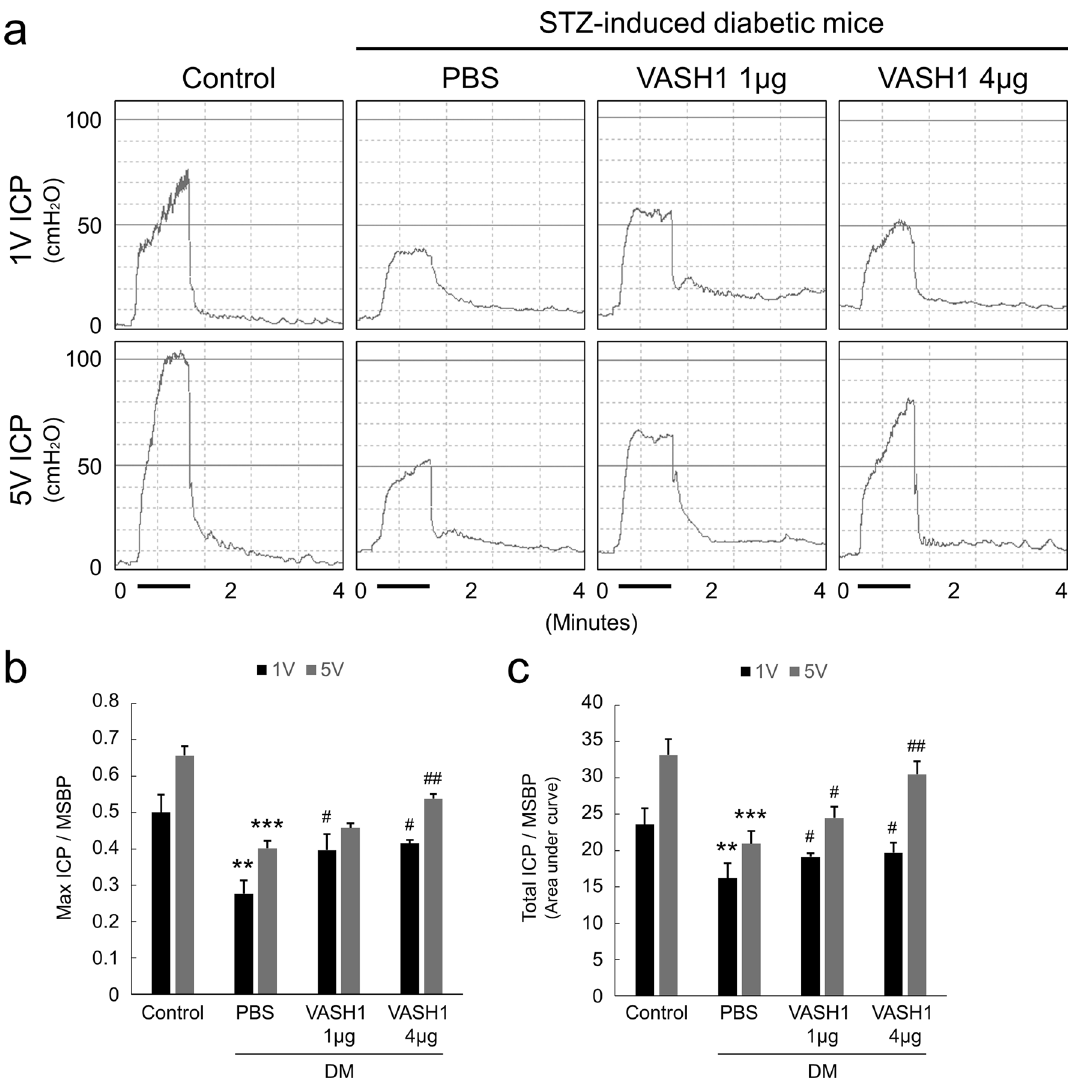
Figure 3. VASH1 protein transfer restores erectile function in diabetic mice. ( a ) Representative intracavernous (ICP) responses for the age-matched control and streptozotocin-induced diabetic mice stimulated at 2 weeks after repeated intracavernous injections of PBS (days − 3 and 0) or VASH1 protein (days − 3 and 0; 1 μg/20 μL or 4 μg/20 μL). The stimulus interval is indicated by a solid bar. ( b , c ) Ratios of mean maximal ICP and total ICP (area under the curve) to mean systolic blood pressure (MSBP) calculated for each group. Each bar depicts the mean (± SE) values from N = 6 animals per group. ** P < 0.01 and *** P < 0.001 vs. control group. # P < 0.05